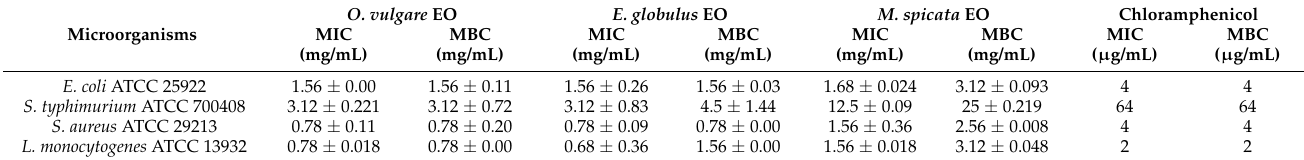
Table 4. MIC and MBC values of the essential oils of O. vulgare, E. globulus and M. spicata